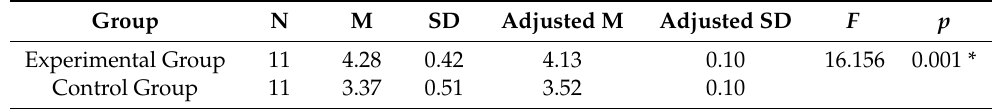
Table 4. The ANCOVA result of the learning attitude for the two groups. Group N M SD Adjusted M Adjusted SD F p Experimental Group 11 4.28 0.42 Control Group 11